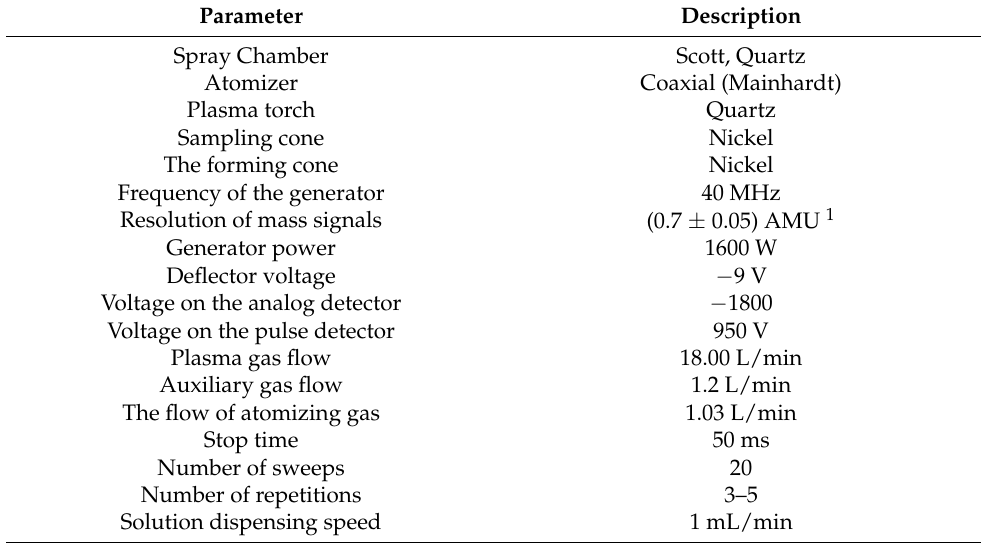
Table 2. Optimal measurement conditions of iron and zinc analysis by the ICP-MS